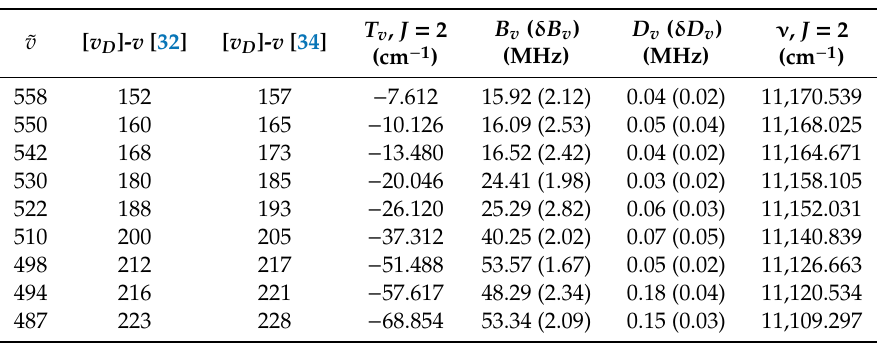
Figure 2. Six typical BPAS of the vibrational levels ˜ v = 558, 550, 542, 530, 522, 510, of ultracold Cs 2 0 + u (6S 1 / 2 + 6P 1 / 2 ) long-range state. The intensities of the PA laser beams (I and II) were 56 W / cm 2 and kept unchanged. The Ti:sapphire laser slowly scanned with stringent linearity. The colorful curves are the multipeak Lorentzian fits. The J = 0 rotational progressions for the levels with small binding energies, which are usually quite close to the J = 1 ones, are denoted as circles. The influences on the fluorescence due to the switch of the shutters are shown in the ellipses. The case for ˜ v = 550 progression is zoomed in the inset, where the N and J = 6 indicate the spectrum produced by the Beam I scans, while N (cid:48) and J (cid:48) = 6 are for the Beam II scans. The N feature could stem from the strong perturbation [36] from the neighboring 0 − g and 1 g states. Actually, in previous studies on the Cs 2 0 − g (6S 1 / 2 + 6P 1 / 2 ) long-range state [35], we had also observed the same phenomena. The separation between the N and N (cid:48) features is ∆ ν = 220 MHz, as expected. Table 1. Rotational constants B v and centrifugal distortion constants D v of 7 low-lying ro-vibrational levels in the 0 + u state below the Cs 2 dissociation limit 6S 1 / 2 + 6P 1 / 2 . The numbering of the levels [ v D ]- v from Ref. [34] has been corrected [32] in the current study and has been assigned as ˜ v , as listed in the table. The binding energies T v , are related to J = 2 of each level, whose PA laser frequencies have also been provided as ν . The ˜ v = 510 case is listed for reference, ˜ v = 498 has been corrected compared to former studies